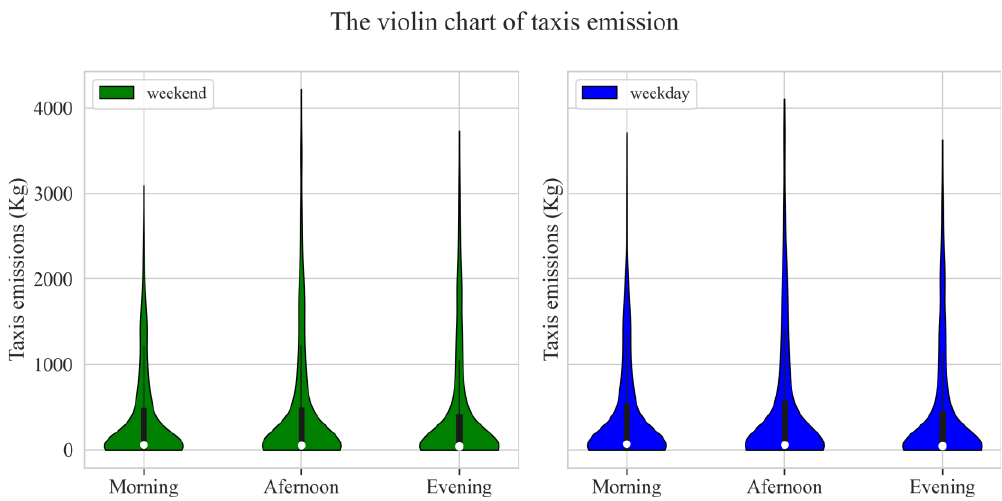
Figure 4. The violin diagram of taxis’